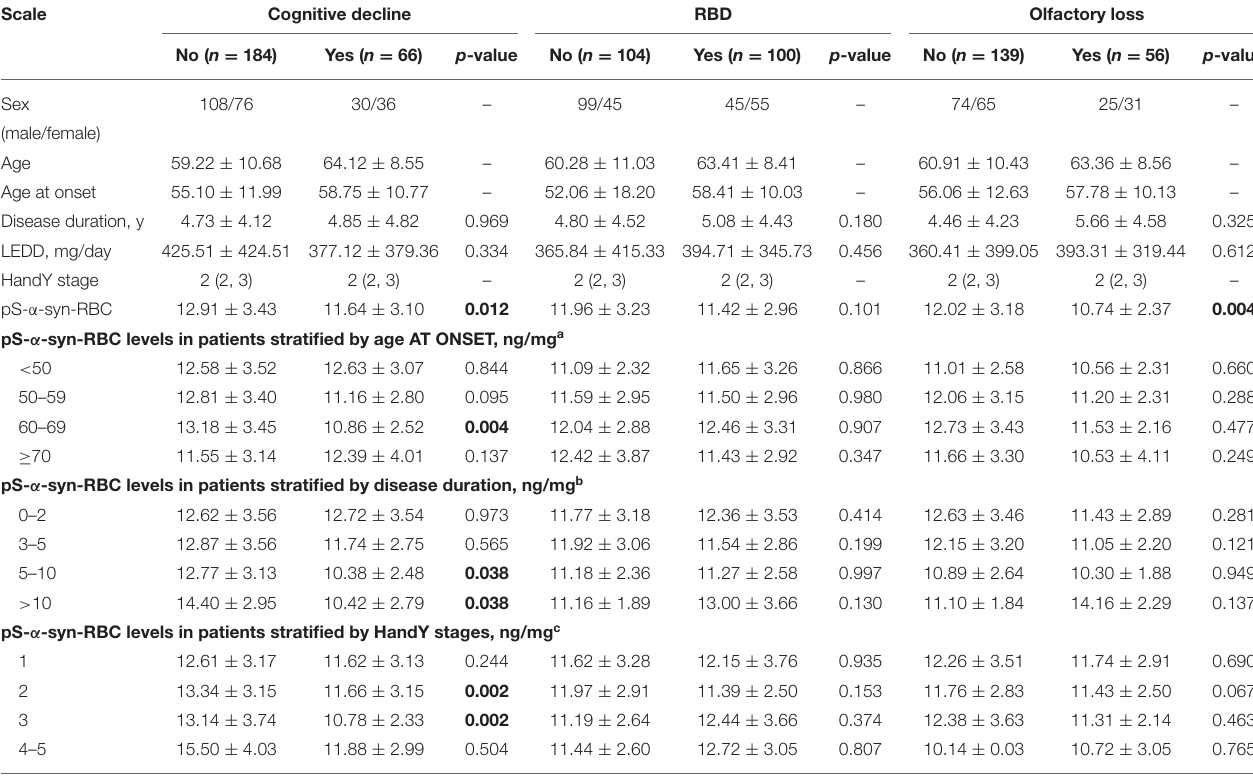
a , c Covariance analysis adjusting for sex, disease duration, and LEDD; b Covariance analysis adjusting for sex, age and LEDD. Definition of abnormal: for cognitive decline, MoCA score cut-offs of 17 (illiteracy), 20 (primary school education), 23 (secondary school education) of 30 points; for RBD, a cut-off of 19 on the RBDQ-HK score; for olfactory loss, a cut-off of 22 on the AHRS score. Bold values: p <